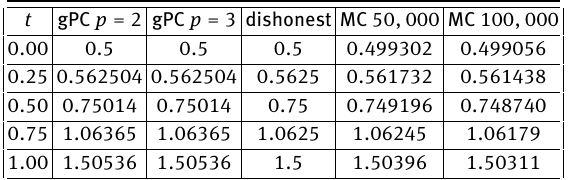
Table 10: Approximation of E [ X ( t )] . Example 4.3, assuming independent random data.